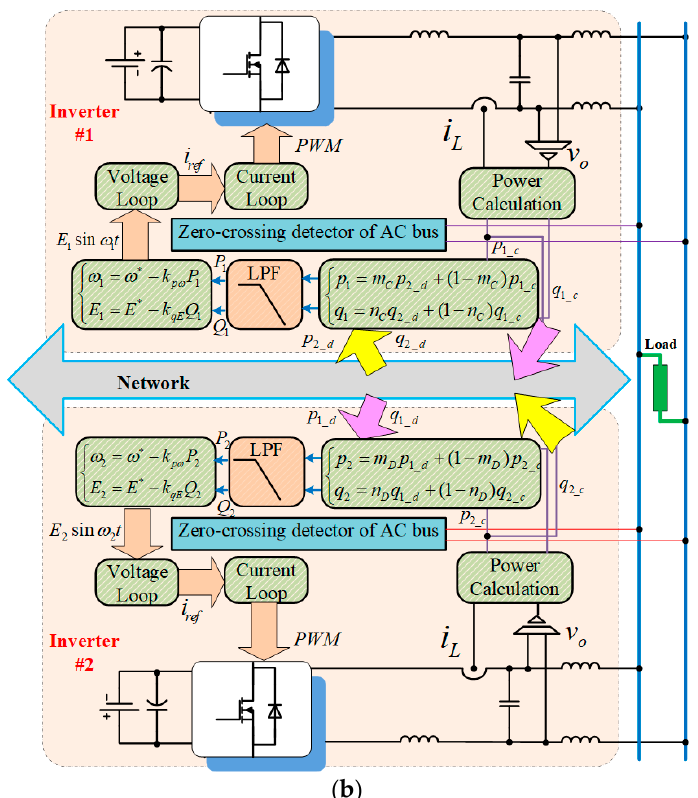
Figure 4. Two methods of network-based control system for parallel operation with two inverters. ( a ) Steady Power Method (SPM), ( b ) Transient Power Method (TPM).